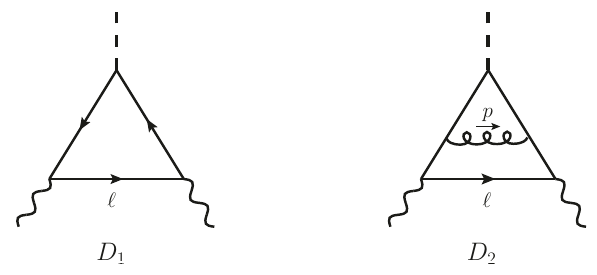
Figure 1 . Sample diagrams contributing to the b -quark induced h ! (cid:13)(cid:13)